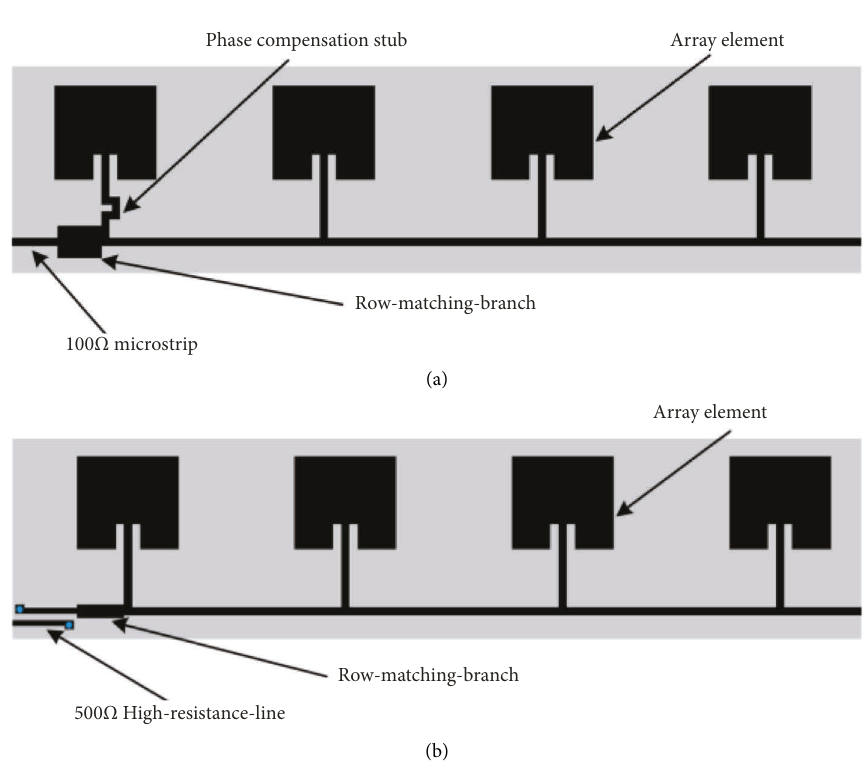
Figure 9: Element arrangement of the row array. (a) Section A. (b) Section